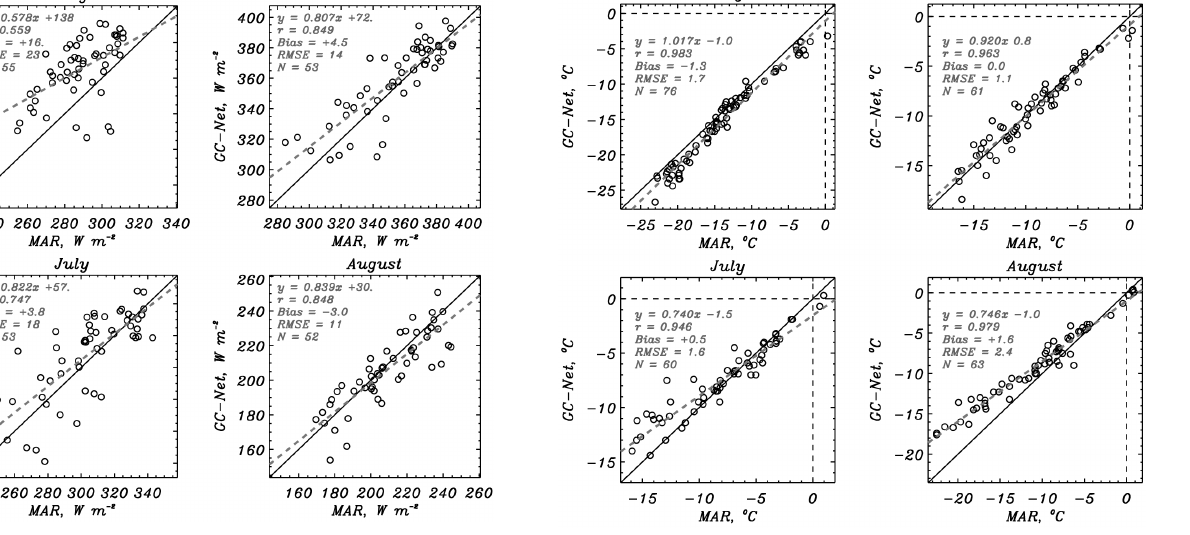
Fig. 3. Comparison of monthly averaged MAR simulations of sur- face air temperature with observations from GC-Net automatic weather stations for the 2000–2010 when GC-Net T air data are available for this study.